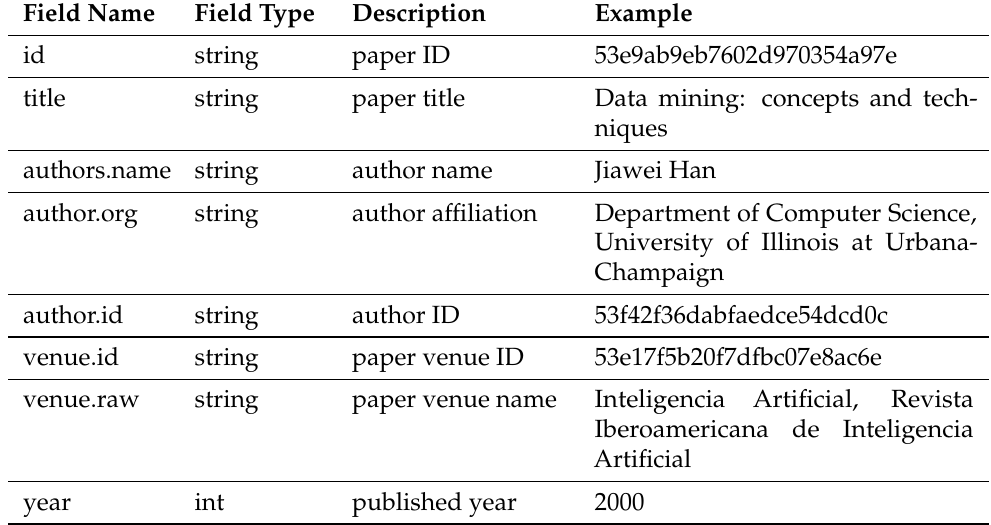
Table 1. Data schema of the citation network